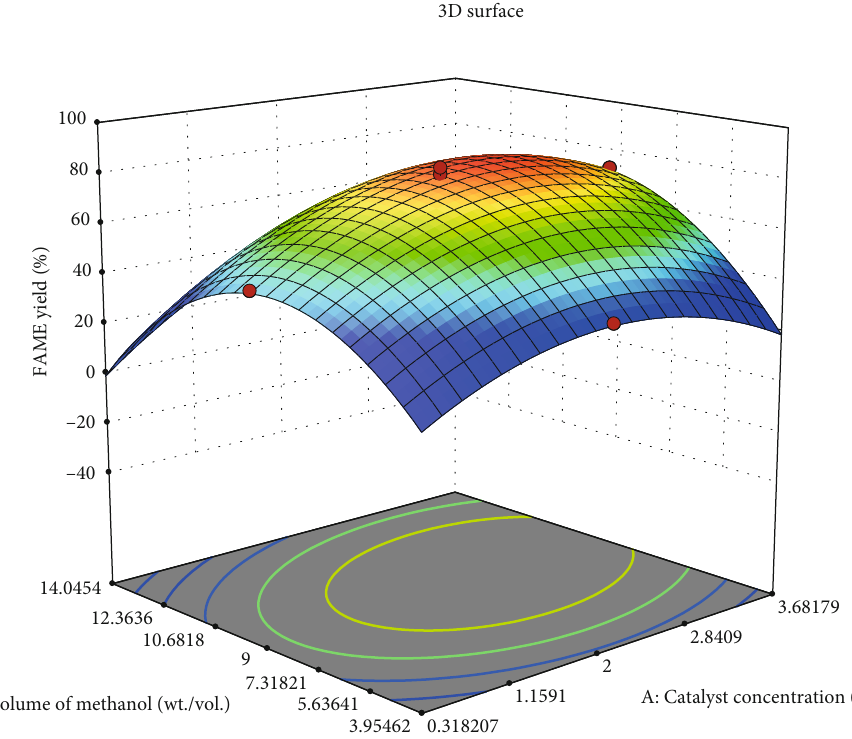
Figure 5: RSM plot: e ff ect of catalyst concentration ( H